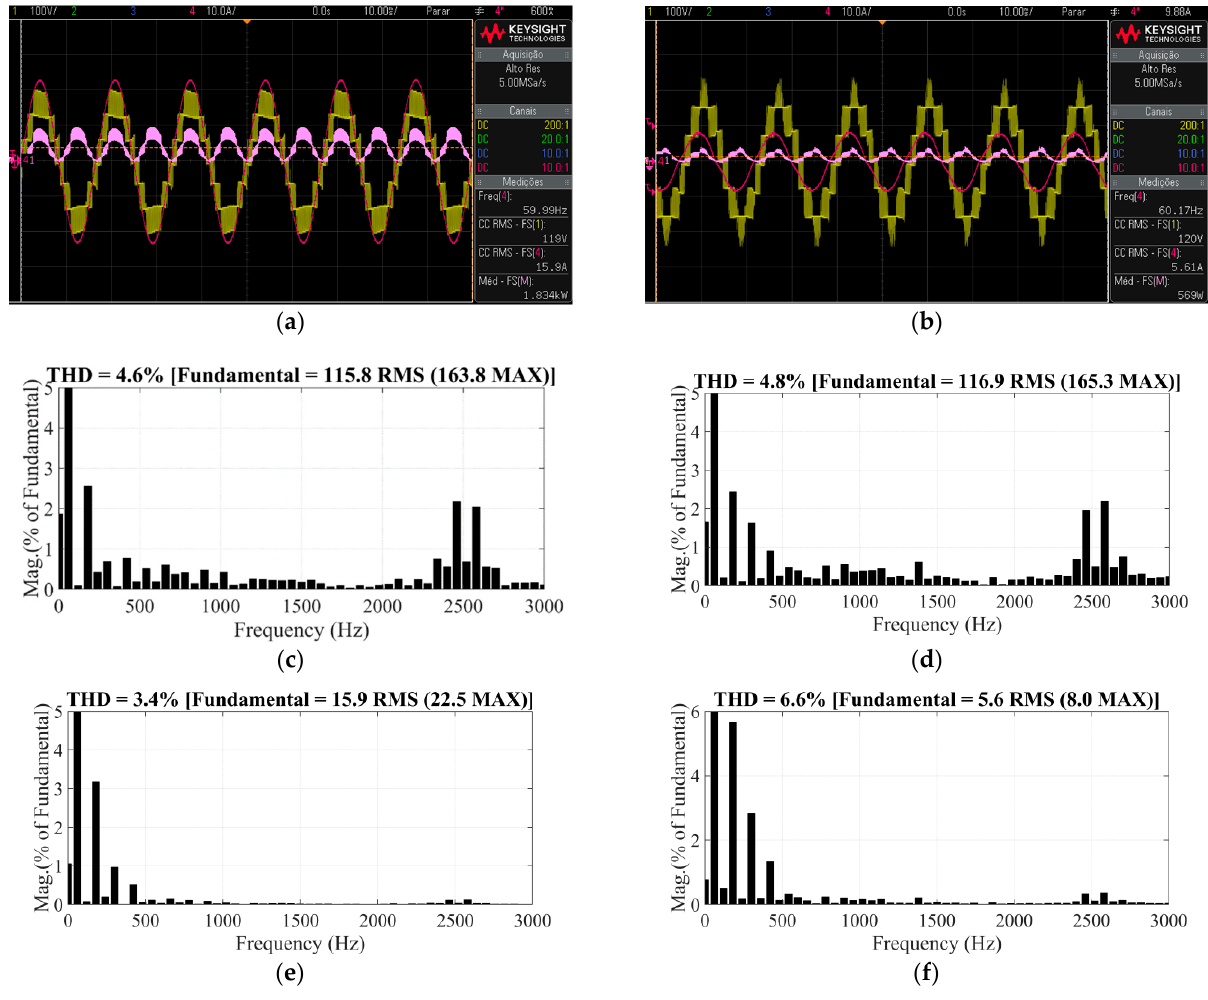
( b ) Figure 8. ( a ) Experimental setup for the seven levels cascaded H-bridge inverter; ( b ) Photovoltaic panels: Sun Earth PV-Module 235 W. 4.2. Experimental Results Figure 9a contains the waveforms for the CHB-ML output voltage (yellow), current (red) and power (magenta) injected into the electrical grid during irradiation of 1250 W/m 2 . Still for this situation, the inverter voltage and current harmonic spectra are shown in Figure 9c,e, respectively. Figure 9b contains the waveforms for the voltage (yellow), current (red) and power (magenta) during irradiation of 300 W/m 2 . The harmonic spectra for both the inverter voltage and output current are shown in Figure 9d,f, respectively.